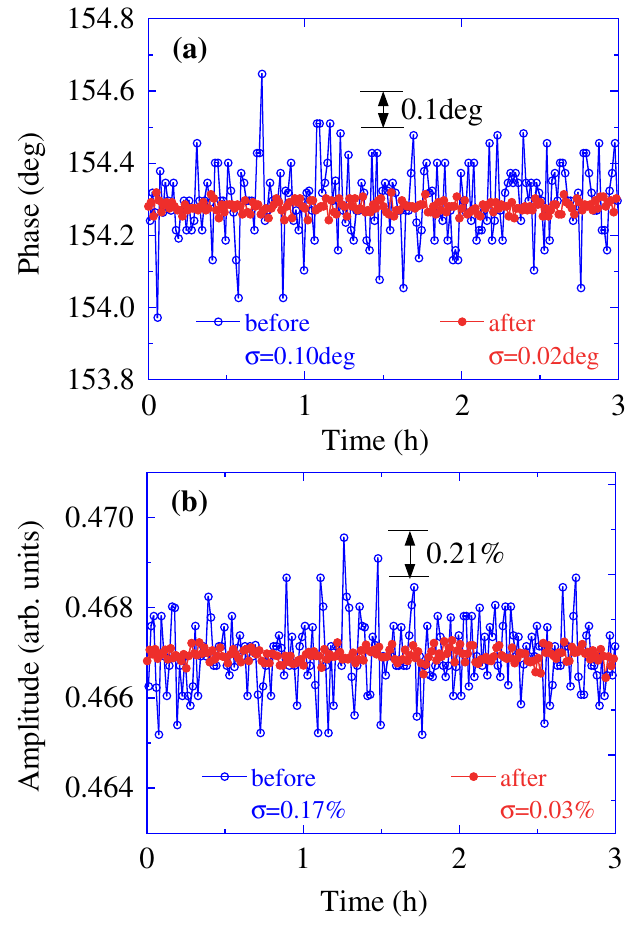
FIG. 8. (Color) Achieved stabilities of the rf phase (a) and the rf amplitude (b) for the SHB over a 3-h period. The open and filled circles represent the stabilities before and after the improve- ments,